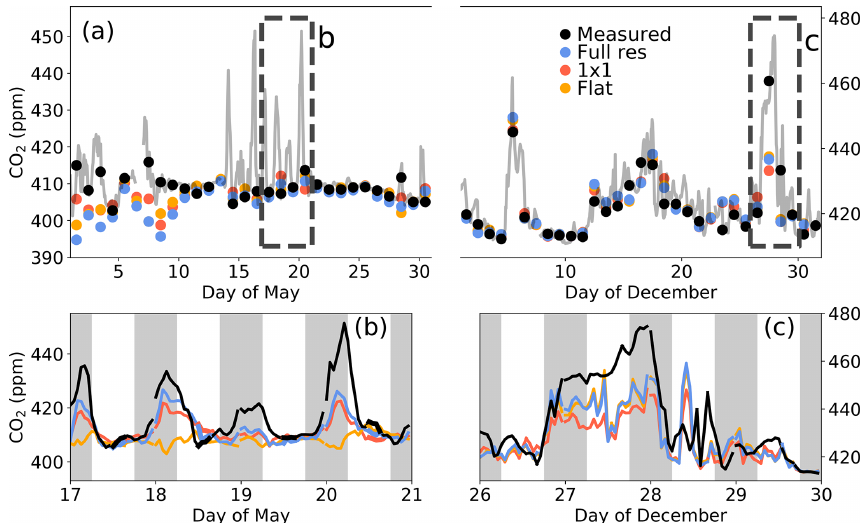
Figure 8. (a) Measured CO 2 time series at Lutjewad in the north of the Netherlands (53.24 ◦ N, 6.21 ◦ E) (grey lines), with a daily mean during well-mixed conditions (12:00–16:00 local time) indicated by black dots. Colored dots indicate afternoon mean (12:00–16:00 local time) modeled mole fractions for STILT transport of our flux product at full resolution (blue), transport using a 1 × 1 ◦ coarsened version of our fluxes (red), and a version of our fluxes with flat diurnal cycles (orange). Panels (b) and (c) show zooms of (a) for May and December, respectively, with the full modeled time series. The periods between 18:00 and 06:00 are marked in grey to indicate the